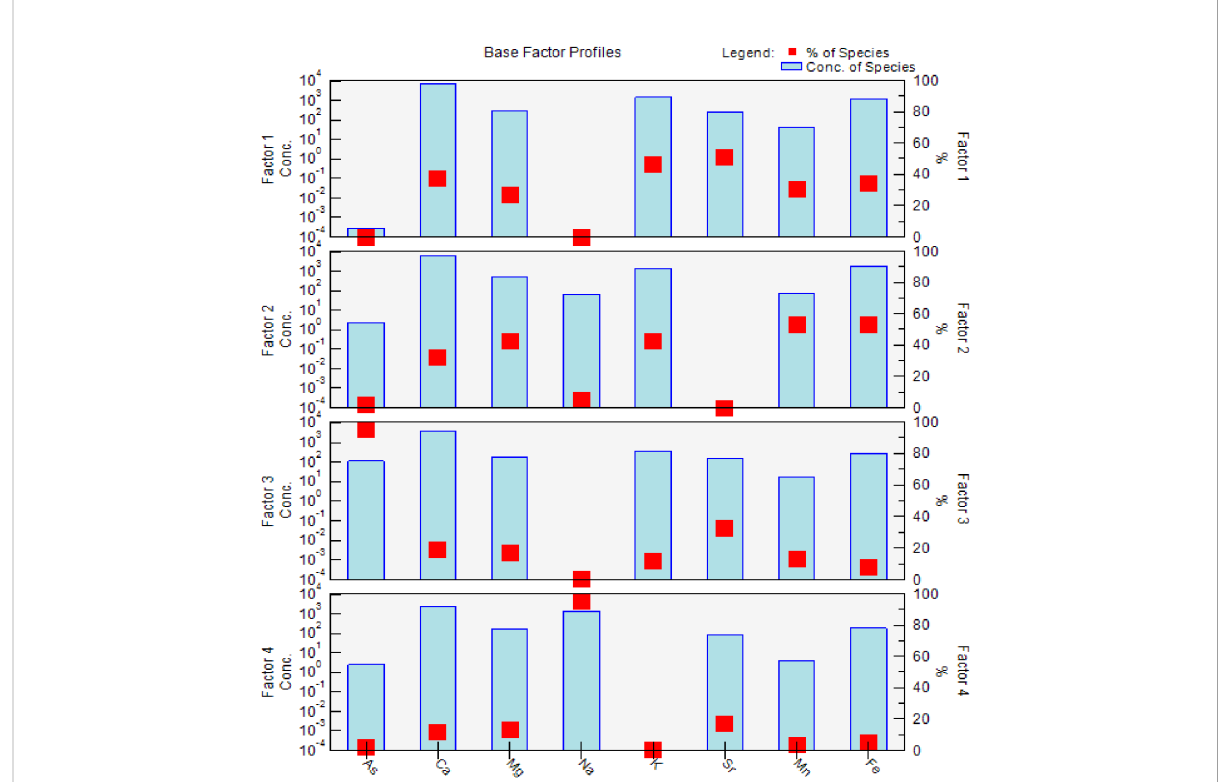
FIGURE 7 Factor pro fi les and source contributions of metal concentrations from PMF for recreational